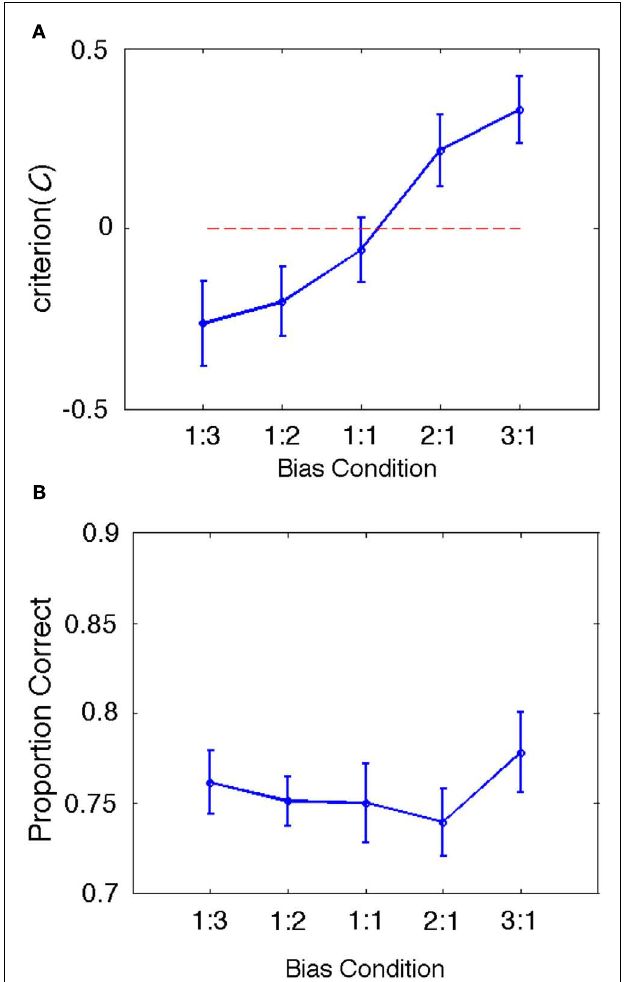
FIGURE 3 | (A) Group behavioral results for our bias measure, C .The data are plotted as a line graph where the x -axis is the same-different ratio and the y -axis is the group mean value of C . Error bars reflect ± one standard error of the mean.The zero criterion value (no bias) is plotted as a dotted line in red. Clearly, C varies significantly in the expected direction (negative values indicate bias toward responding “different” and positive values indicate bias toward responding “same”). Also, the mean criterion value in the 1:1 bias ratio condition is closest to zero (and contains zero within ± 1SE), as expected. (B) Group behavioral results for proportion correct (PC). Although PC varied slightly across conditions, this variability is likely accounted for by shifts in bias, which affect PC but not bias-corrected measures like d (cid:2)